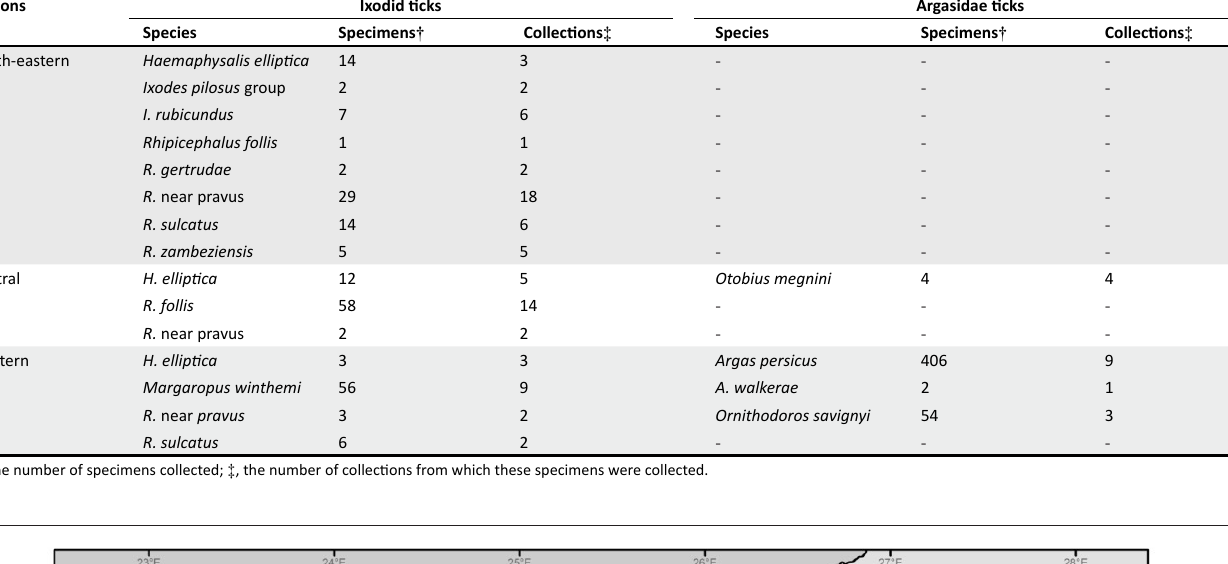
TABLE 2: Ixodid ticks of lesser importance and argasid ticks identified from each of the three collection regions. Regions